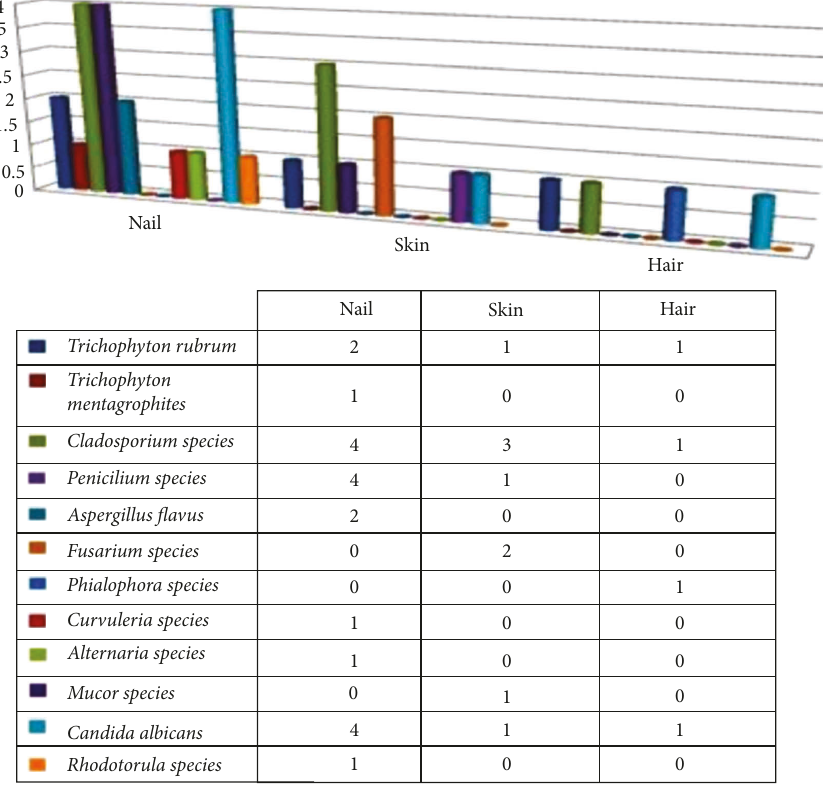
Figure 6: Frequency of fungal isolates from nail, skin, and hair amongst culture-positive cases. Table 5: Distribution of fungal isolates concerning clinical